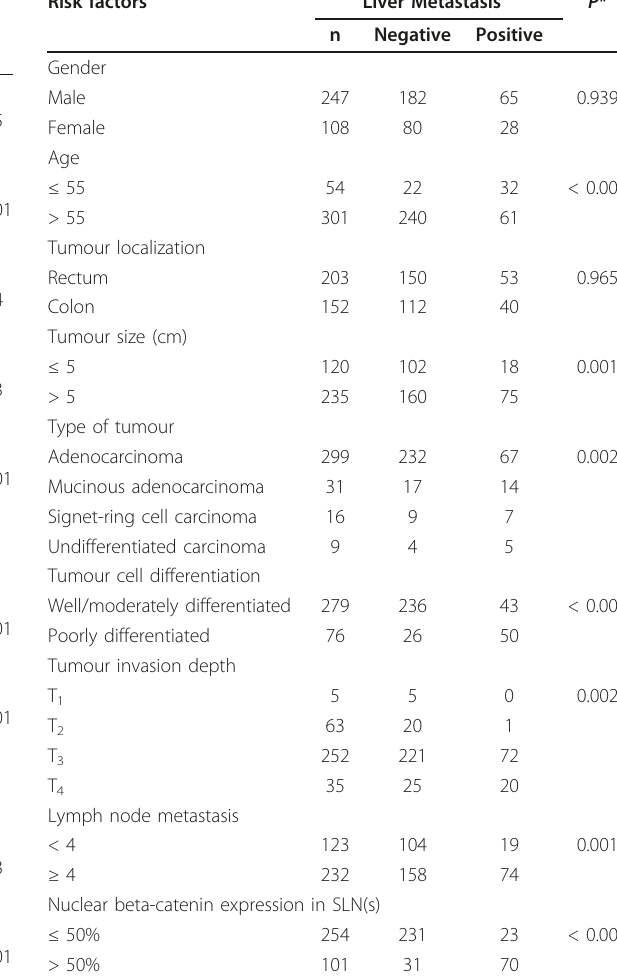
Table 2 Correlation of nuclear beta-catenin expression in SLN(s) with clinicopathological characteristics Characteristics